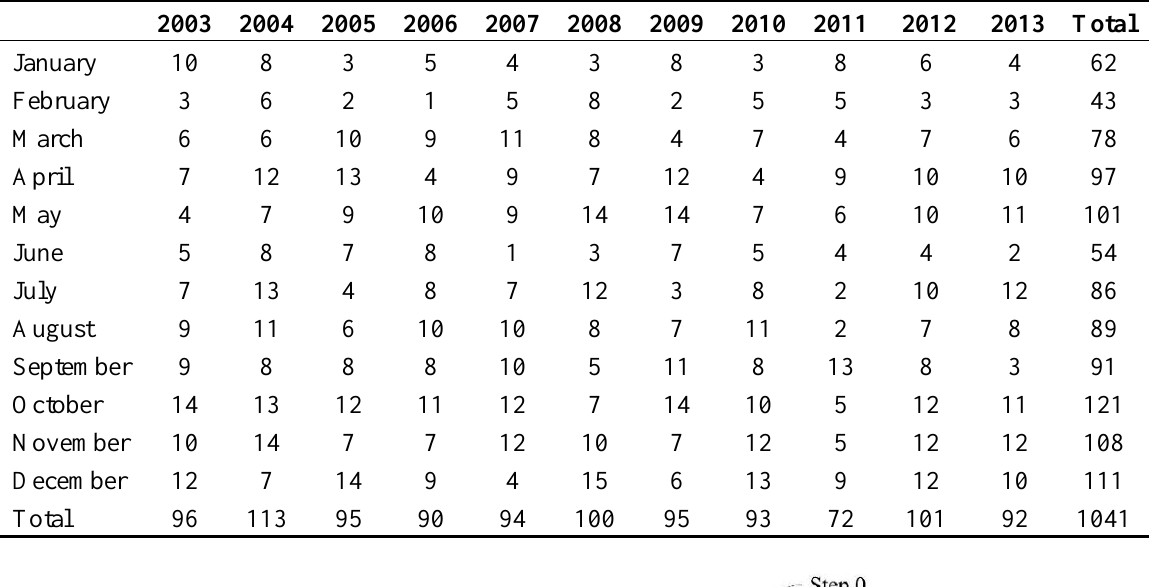
Table 2. Temporal distribution of the MODIS-Aqua images used in this study.